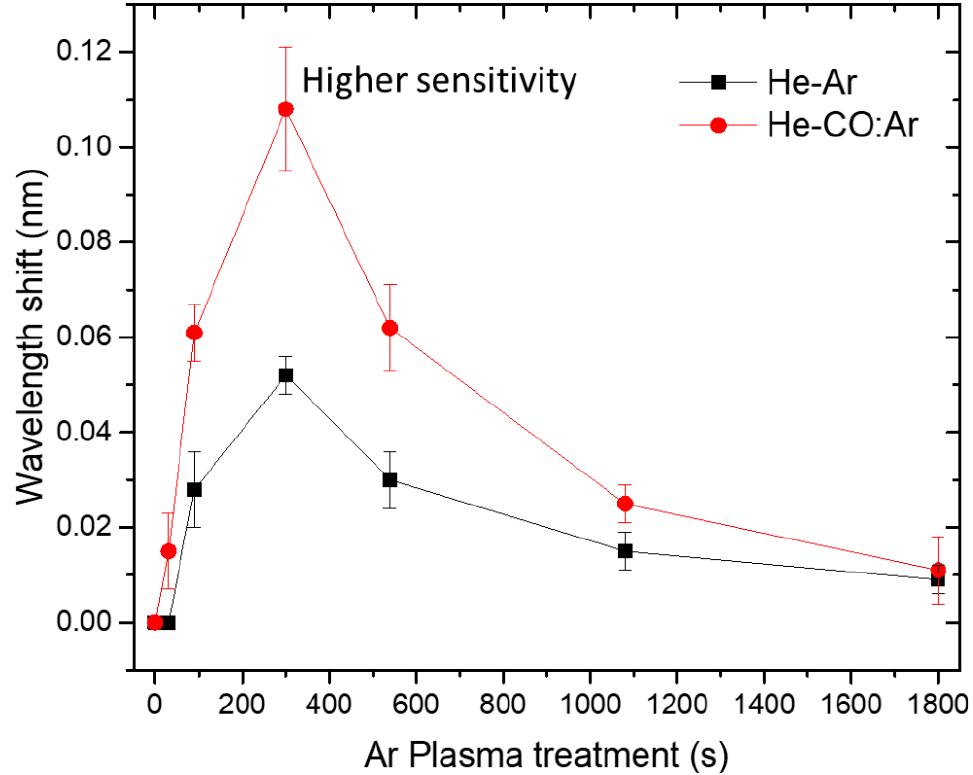
Figure 7. Average wavelength shift of the LSPR band of the Au:CuO film, as a function of the Ar plasma treatment, for 5 cycles of He-Ar and He-CO:Ar. Table 2. Optical response parameters of the He-Ar and He-CO:Ar tests as a function of Ar plasma treatment time.